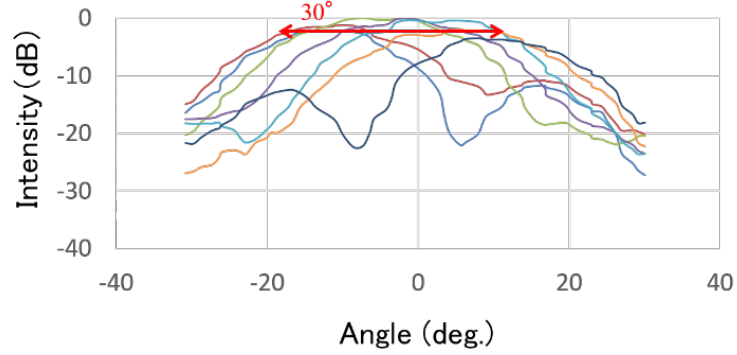
Figure 7. Measured intensity when the beam is steered.